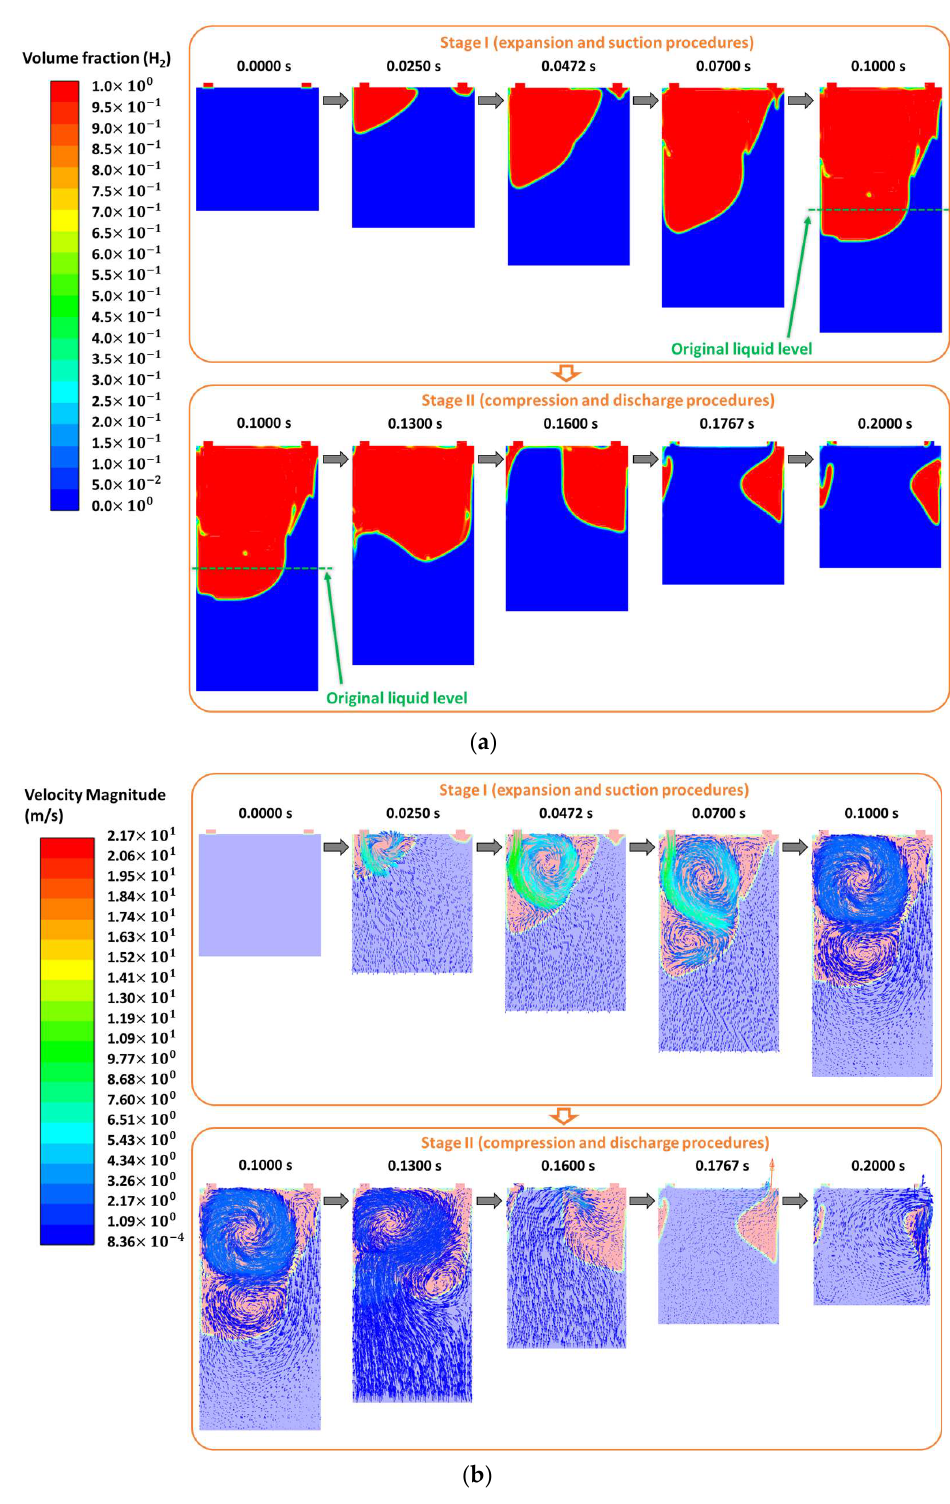
Figure 7. Results of the ( a ) volume fraction distribution and ( b ) velocity distribution (density of the ionic liquid: 1450 kg/m 3 ).